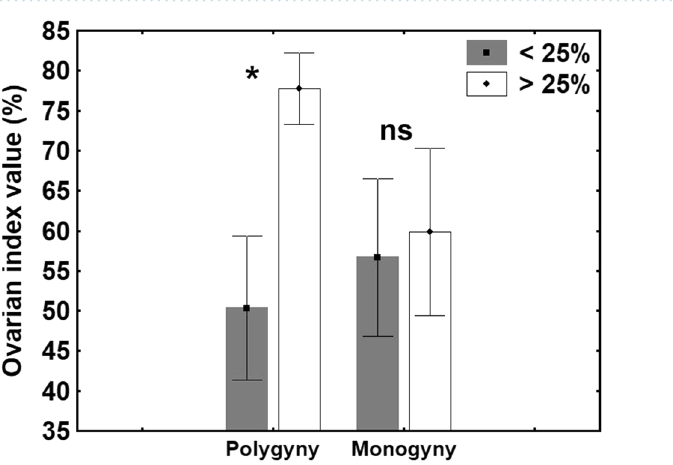
Figure 3. Mean number of eggs laid over a 24-h period (mean ± SE) by each low-fecundity queen (n = 7) ( a ) and each high-fecundity queen (n = 7) ( b ) under polygynous and monogynous conditions. The asterisks denote significant differences (* p < 0.05; ** p < 0.01); ns: no significant differences.